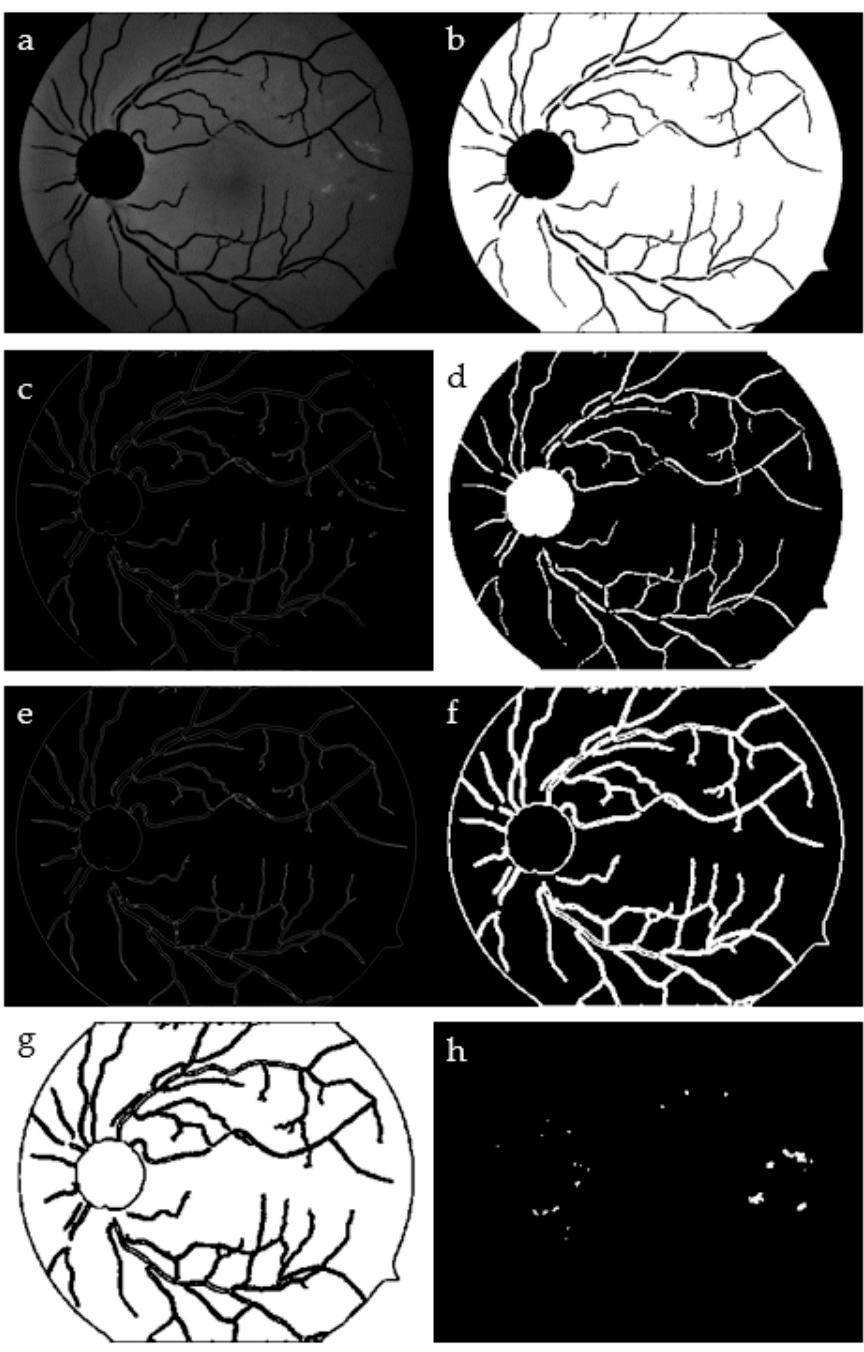
Figure 6. Expected exudates: I G —green channel image ( a ); I D —squared normalized image of I G ( b ); I S —binarized Sobel image of I D ( c ); I C —complement of I D ( d ); I SC —binarized Sobel of I C ( e ); I DI —dilated I SC ( f ) and its complement ( g ); I OUT —closing and dilation morphological operation ( h ) on both I S and I DI images.